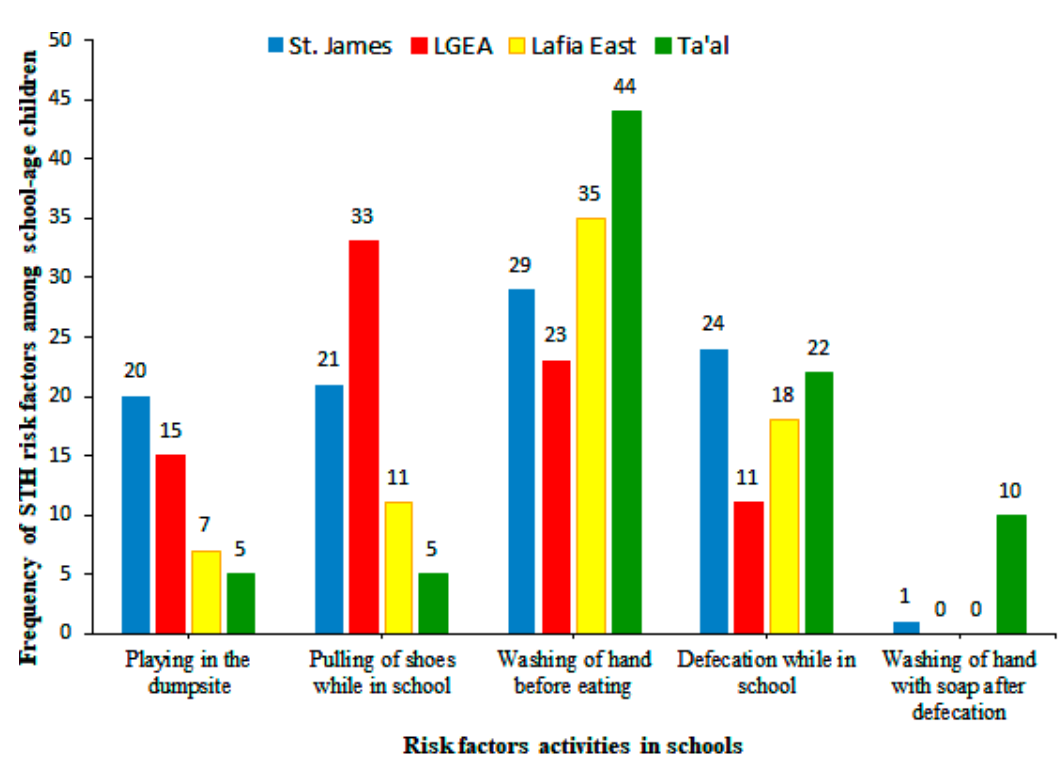
Figure 1. Factors that promote the transmission of soil-transmitted helminths among school-age children in relation to schools.